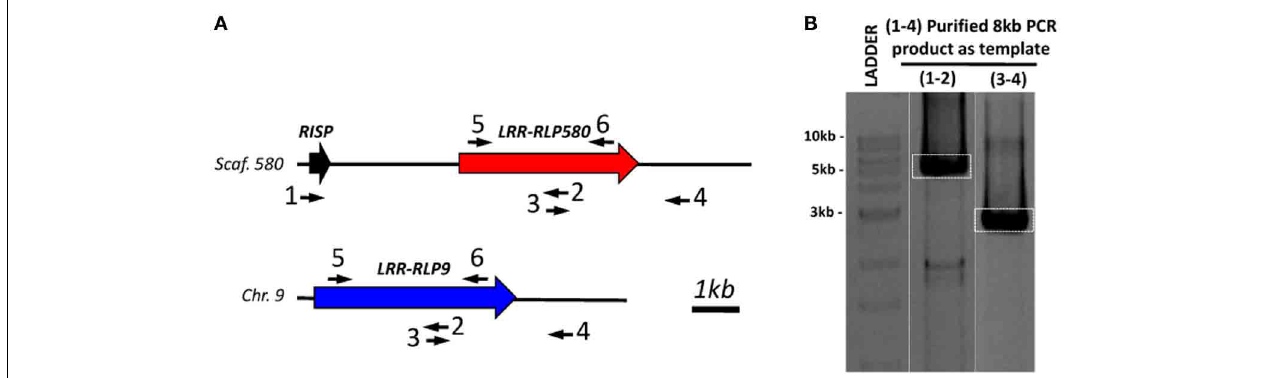
FIGURE 6 | Physical association between RISP and a chimera of LRR-RLP580 and LRR-RLP9 . (A) Schematic representation of the location of RISP , LRR-RLP580, and LRR-RLP9 on P. trichocarpa genomic sequence (Phytozome v2.2). The primers used to amplify and sequence the fragment containing the LRR-RLP associated with RISP are indicated. Note that the primer 1 is specific to the RISP gene whereas primers 2,